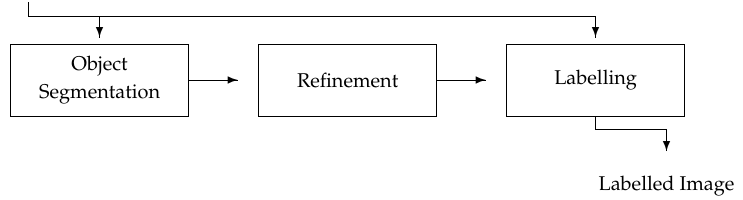
Figure 2. Schematic representation of the USRL schema. Each phase is depicted by a rectangle, with the information flow being represented by